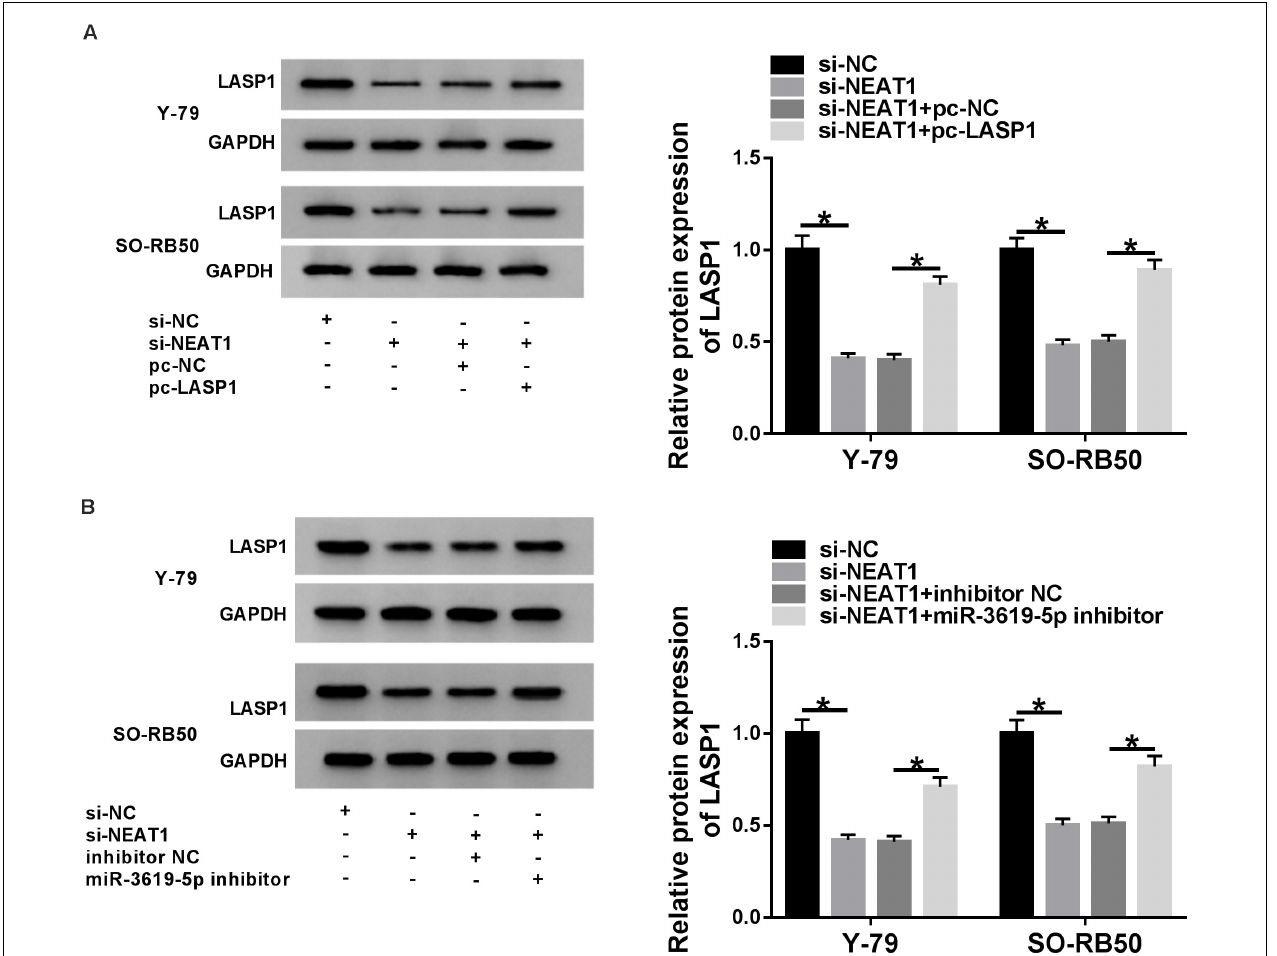
FIGURE 5 | NEAT1 silencing repressed the protein level of LASP1 by regulating miR-3619-5p. (A) The effects between NEAT1 knockdown and LASP1 overexpression on LASP1 protein expression were revealed by western blot. (B) Western blot demonstrated that NEAT1 knockdown repressed the protein expression of LASP1, which was decreased by miR-3619-5p inhibitor. * P <